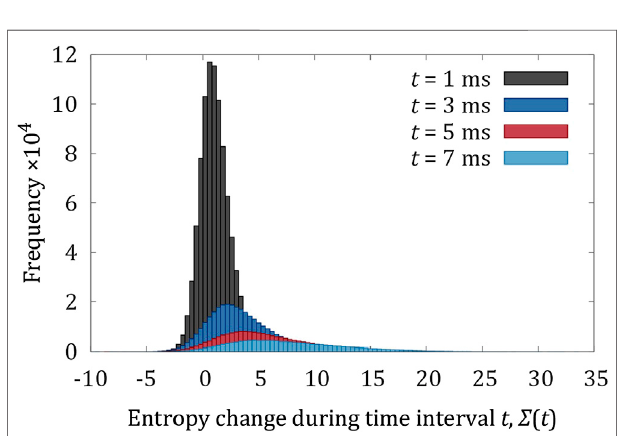
FIGURE 4| Evolution ofthe distribution of entropy change for aseriesof increasing time periods.